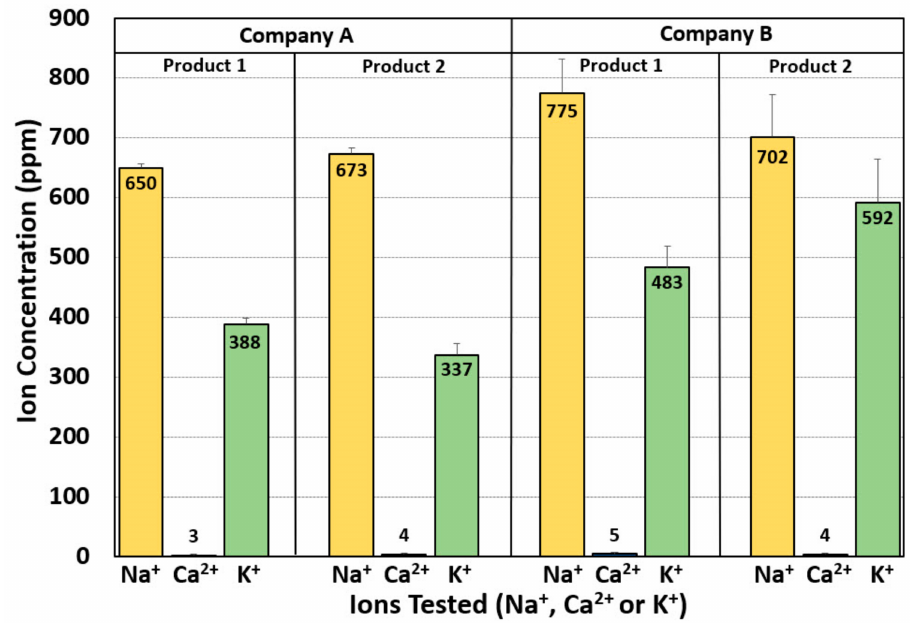
Figure 6. Salt ion analyses of two commercially-available biltong products (Product 1; Product 2) from each of two di ff erent companies (Company A; Company B). Analyses were done in triplicate on each product with errors bars indicating the standard deviation of the